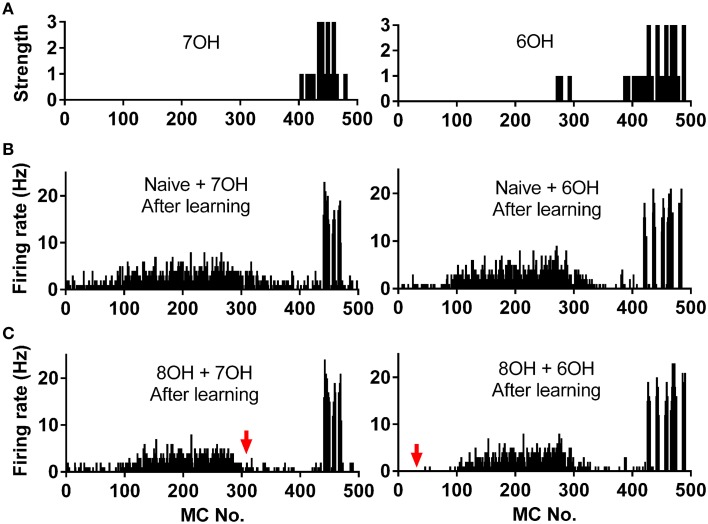
Spatial firing rate patterns of 500 mitral cells. (A) The strength of odor inputs 7OH (left) and 6OH (right) to each mitral cell. (B) The spatial firing pattern of 500 mitral cells during the 4th second after training in response to 7OH (left) or 6OH (right) in the naïve condition. (C) The spatial firing pattern of 500 mitral cells during the 4th second after training in response to 7OH (left) or 6OH (right) in the 8OH experience condition. The red arrow (right) indicates that the firing pattern of the network in response to 7OH in the 8OH experience condition (C, left) differs more than that of the naive condition (B, left) from the firing pattern of the network to 6OH in the naïve condition (B, right). Similarly, the red arrow (left) indicates that the firing pattern of the network in response to 6OH in the 8OH experience condition (C, right) differs more than that of the naive condition (B, right) from the firing pattern of the network to 7OH in the naïve conditions (B, left).